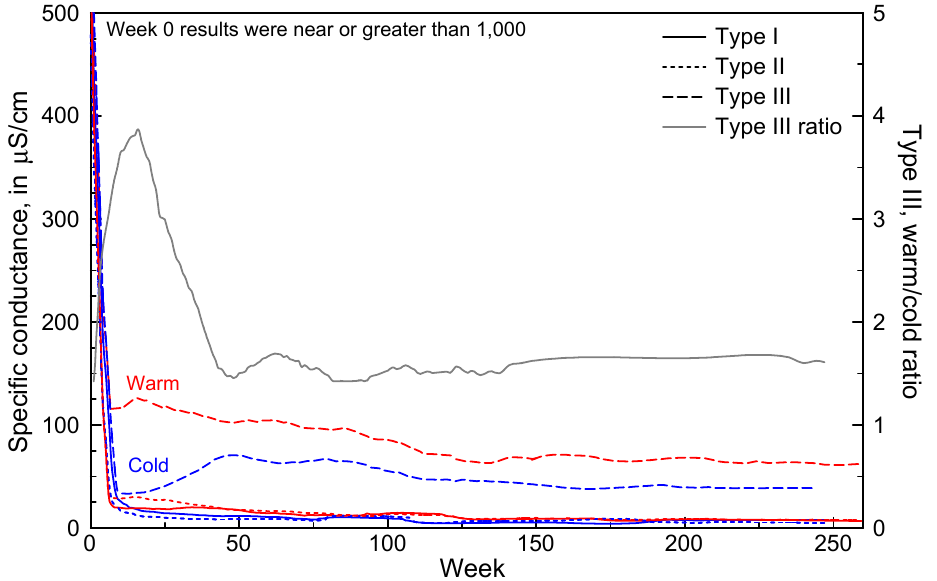
Figure 2. Temporal variation (moving average trendline of a 10-data point window) of the specific conductance of leachate from warm and cold humidity cells and specific conductance ratio of warm and cold Type III waste rock